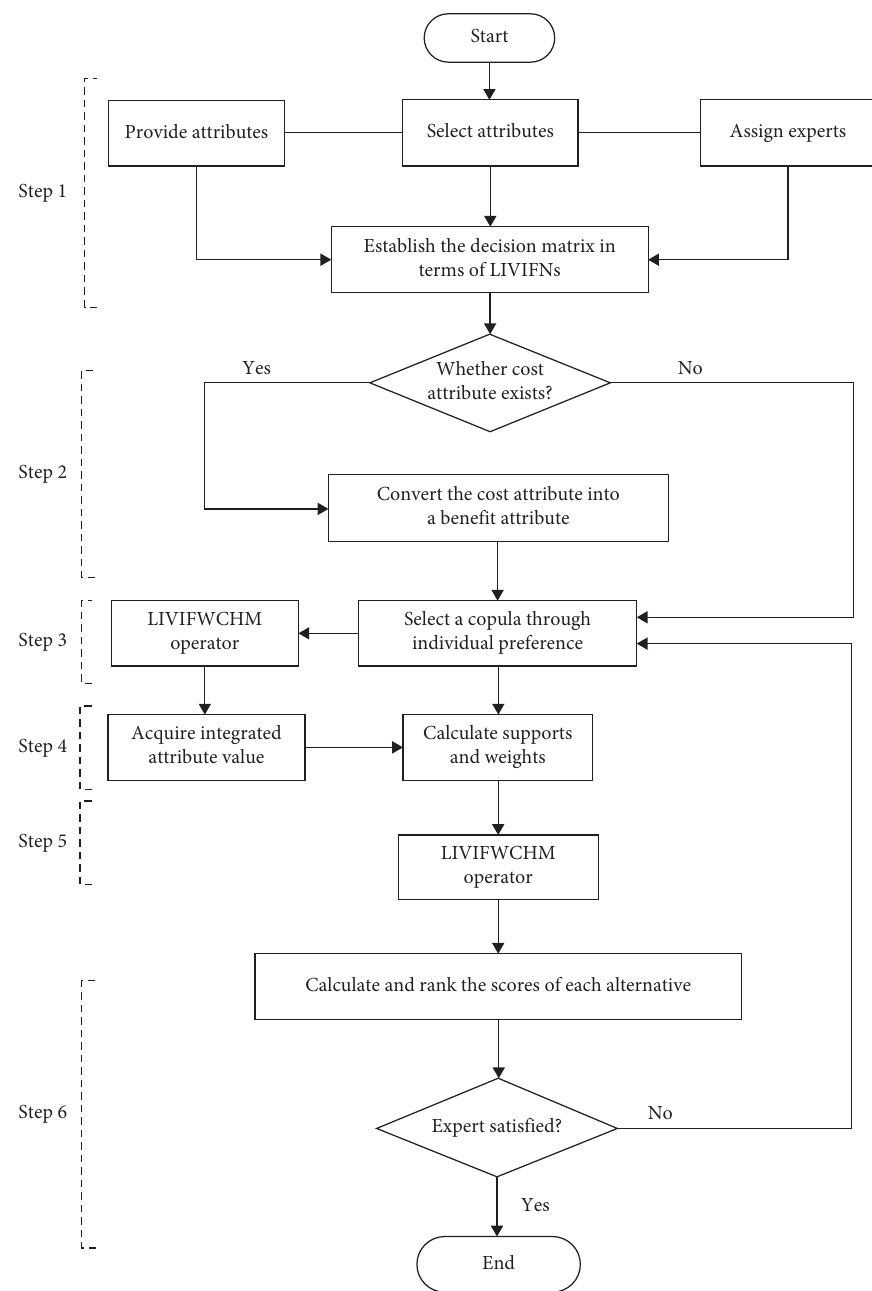
Figure 1: Flowchart of